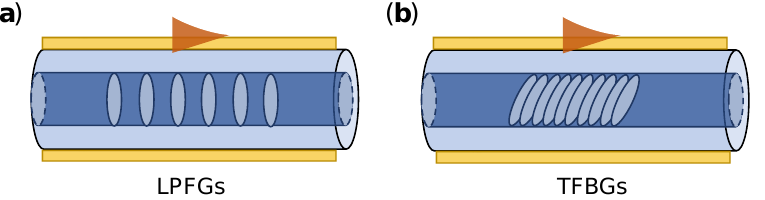
Figure 10. Schematics of the optical fiber grating-assisted SPR- fiber sensors. ( a ) Long period fiber gratings (LPFGs), ( b ) Tilted fiber Bragg gratings